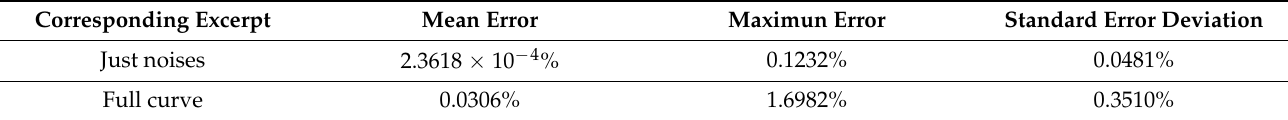
Table 11. Statistical measures: testing D.